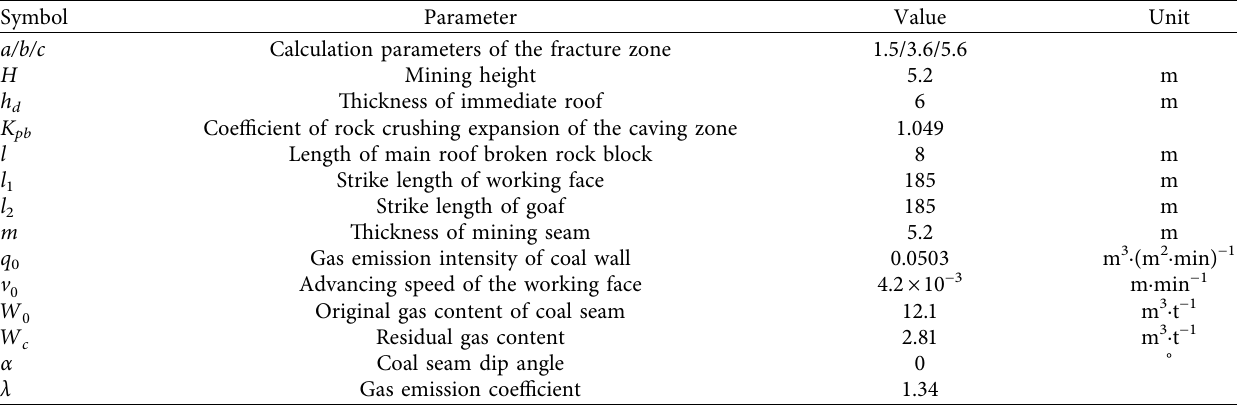
Table 1: Calculation formula parameters’ values.